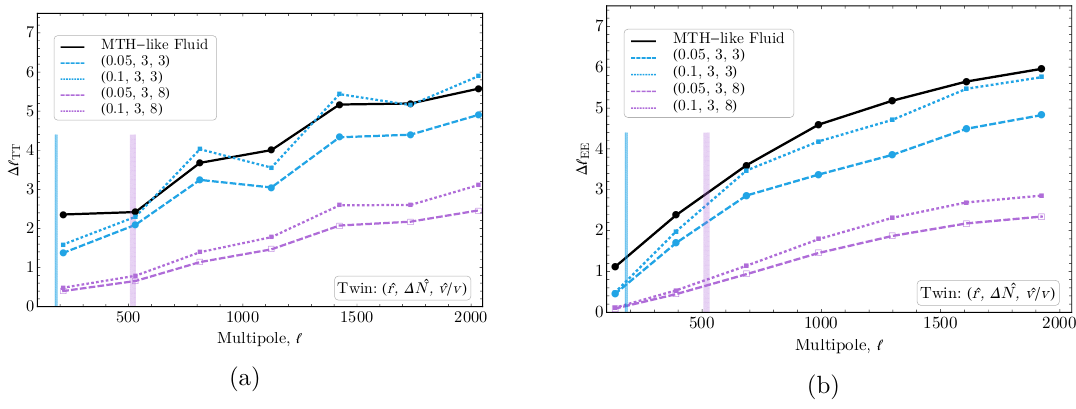
Figure 9. Shift of the ‘ -modes of the peaks relative to the free-streaming radiation scenario in the (left) and C EE (right) spectra, assuming ∆ N = 3 . We connect the result at each peak by C TT eff ‘ ‘ straight lines for visualization purposes. The blue and purple curves are from the MTH models with (∆ ˆ N, ˆ v/v ) = (3 , 3) and (3 , 8) , respectively. Both the dotted blue and purple curves have ˆ r = 0 . 1 and the dashed curves have ˆ r = 0 . 05 . The thick vertical lines indicate the ‘ -modes that mainly receive contributions from perturbations of the mode k = τ − 1 . The left (right) boundary of twinrec the vertical lines indicates ‘ , which is defined to indicate the modes that came into rec ≡ τ 0 /τ twinrec horizon around the twin recombination time, for the dotted (dashed) MTH curves. The δ‘ values asymptote to zero when ‘ approaches ‘ and below. The black curve shows the phase shift of a rec dark-radiation model that contains the same proportion of free-streaming vs. fluid energy density as the ˆ ν and ˆ γ . The MTH curves get closer to the black curve as twin recombination is pushed to later times (smaller ‘ rec